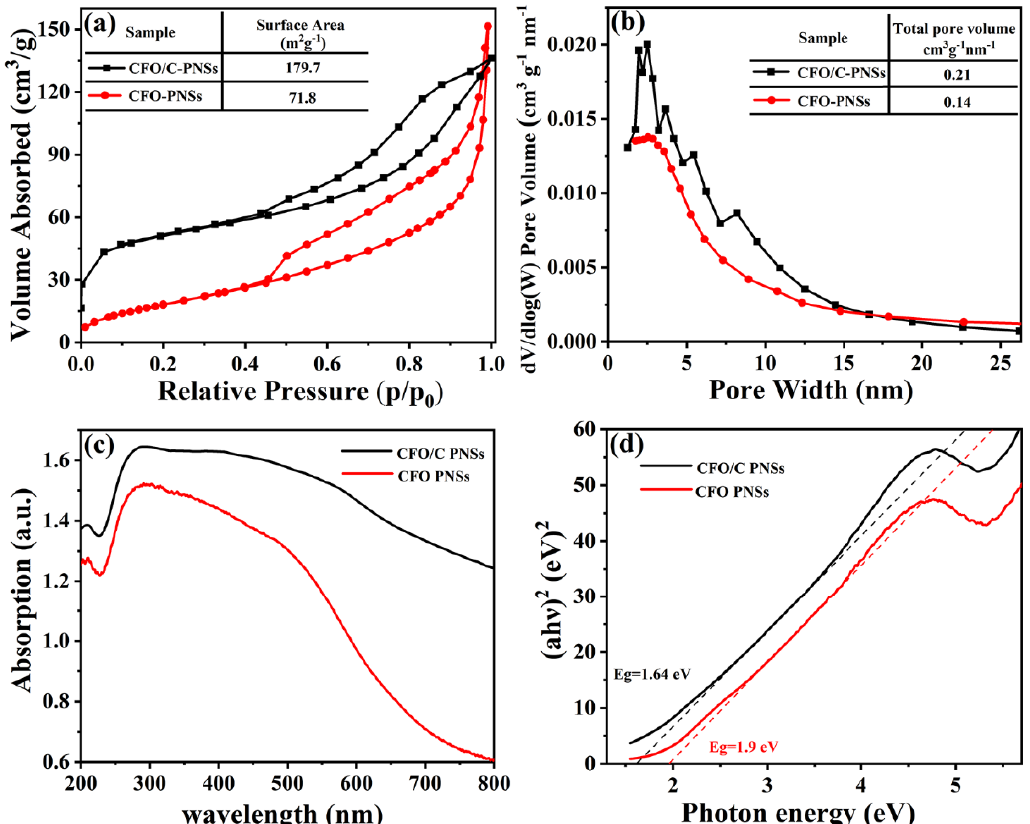
Figure 4. ( a ) N 2 adsorption–desorption isotherms and ( b ) pore size distribution, ( c ) UV–vis DRS spectra and ( d ) the band gap energies (Eg) of CFO/C-PNSs and CFO-PNSs.